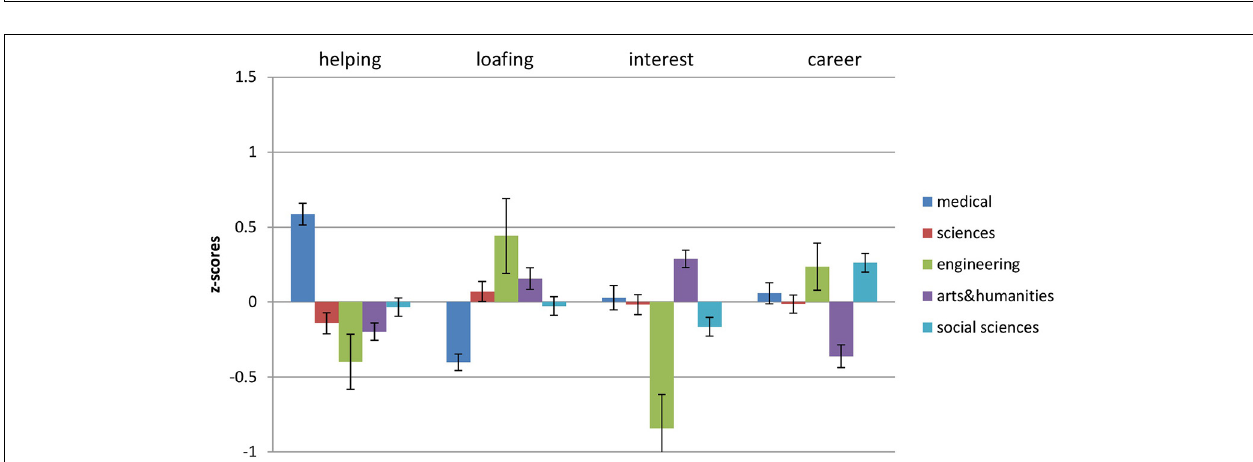
FIGURE 5 | Z-scores for Helping, Loafing, Interest and Career across all degree types in the undergraduate sample. Error bars represent the standard error of the mean.